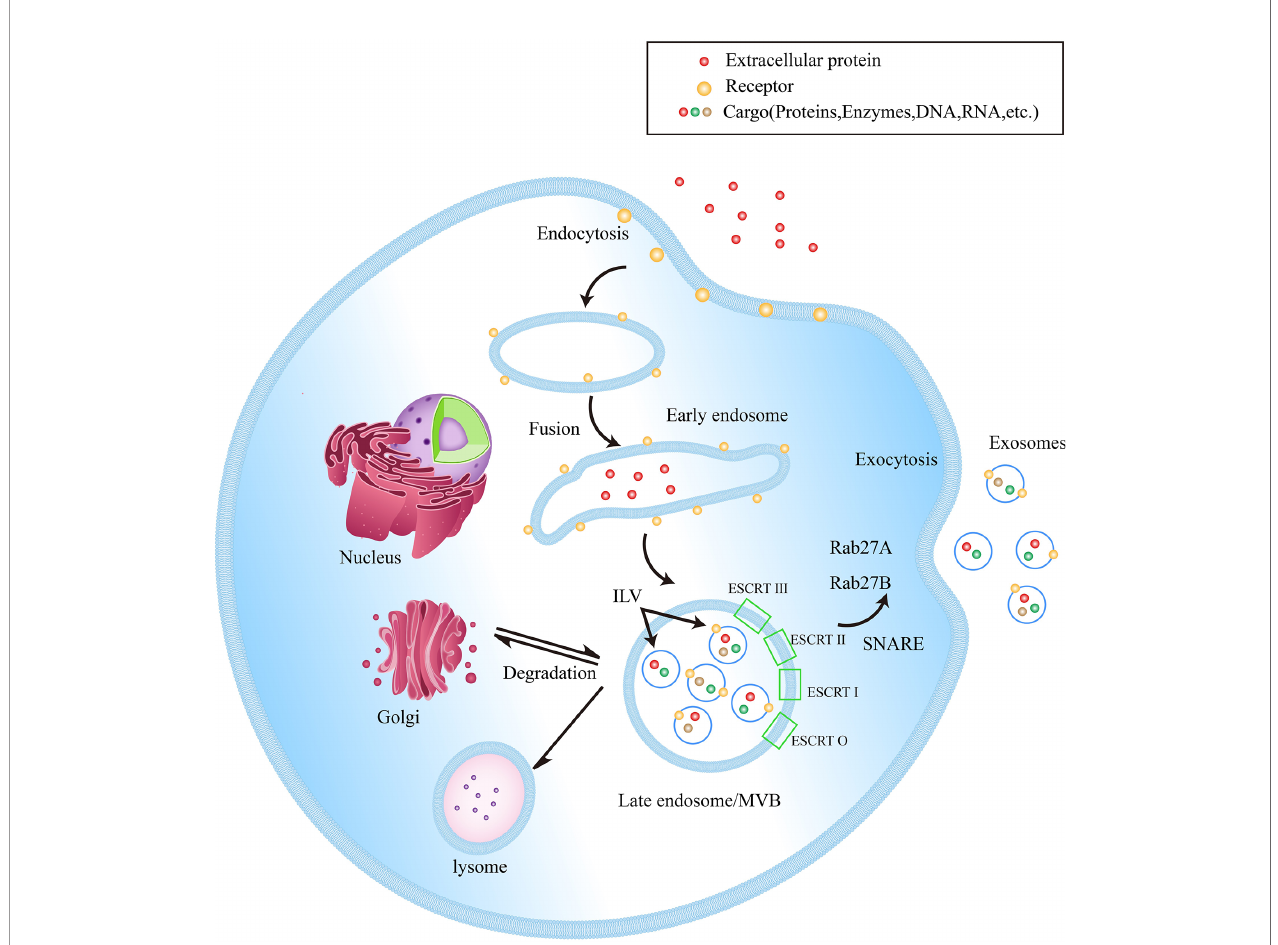
FIGURE 1 | Exosome biogenesis within endosomal system. Early endosomes are formed by the fusion of endocytic vesicles, further transformed into late endosomes/MVBs through inward budding of the membrane (packing the cargo into ILVs). ILVs protein sorting has two methods, ESCRT-dependent and ESCRT- independent. ESCRT-0, ESCRT-I, ESCRT-II and ESCRT-III are the four components of the ESCRT. They generalize the substrate on the inwardly budding endosomal membrane. Subsequently, a part of MVBs is fused with lysosomes to be degraded, while another part of MVBs can be fused with the plasma membrane to release ILVs into the extracellular space, now called exosomes. In addition, Rab27A and Rab27B are important mediators leading MVBs to the periphery of cells, and the SNARE complex helps MVBs fuse with the plasma